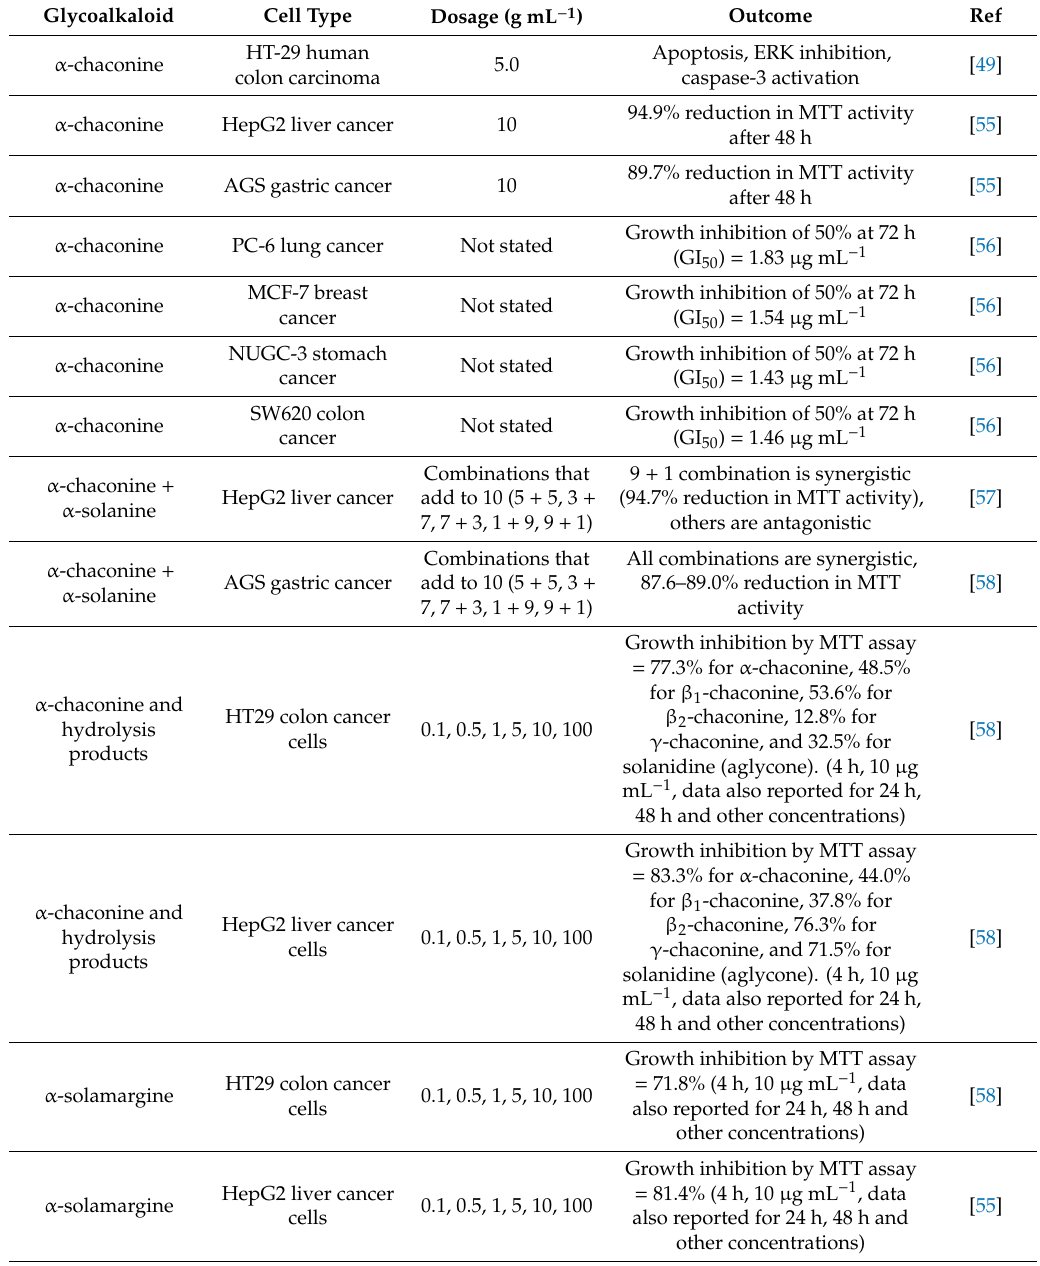
Table 1. Selection of reported data for e ff ect of glycoalkaloids against cancer cells lines, noting doses and specific cellular e ff ects (if reported). Data reported in concentration units (such as µ M) are converted to µ g mL − 1 . Data is not shown for